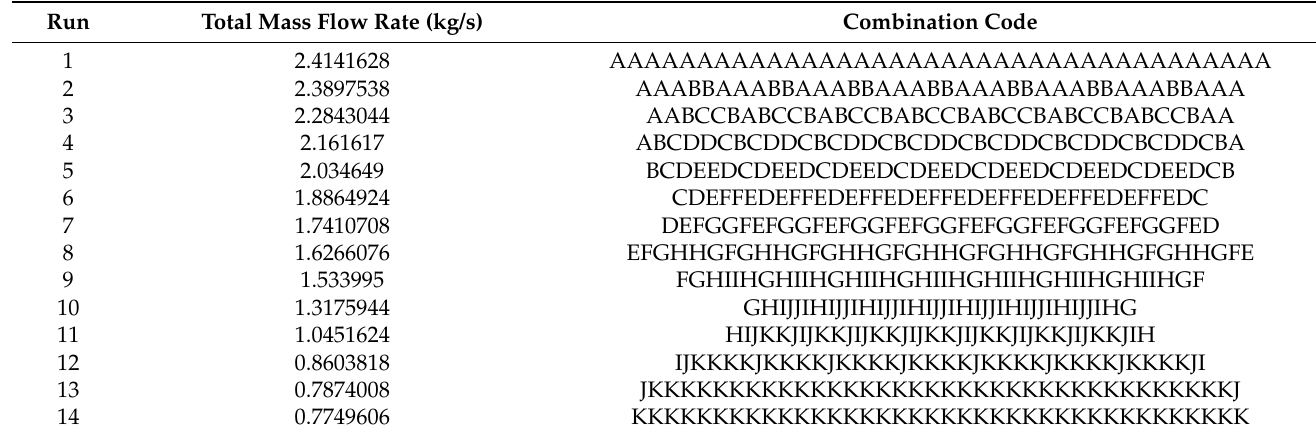
Table 8. Combinations of mass flow rates for seven stall cells.